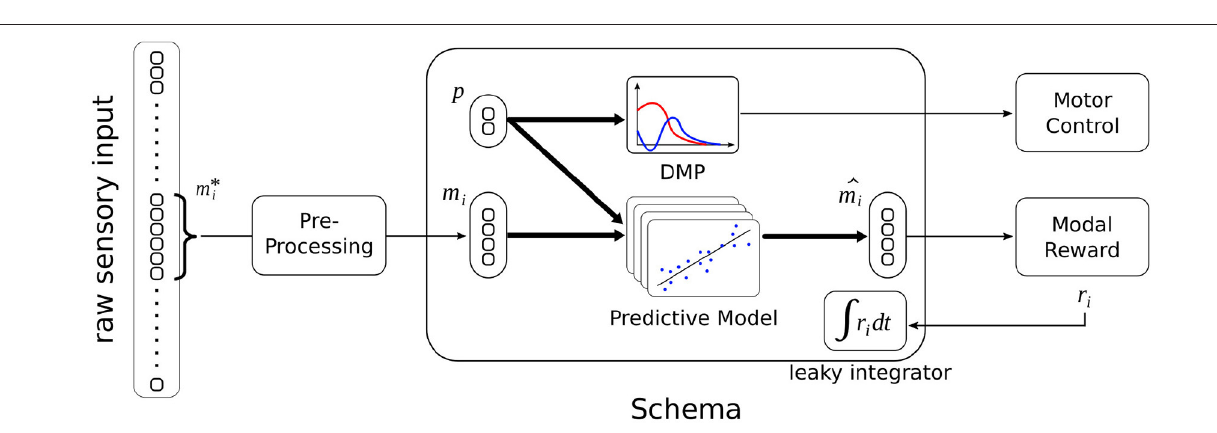
FIGURE 3 | Schematic illustration of the sensorimotor schema in context. Raw sensory data from a specific modality m ∗ i is pre-processed into a lower-dimensional representation m i . After training, given the current modal percept m i and some action parameterized by p , the schema can predict the resulting sensory percept ˆ m i , and get the associated reward r i through the Modal Reward component. Some experiments use the leaky integrated value of the reward (refer to Section 4.6). When the schema is triggered, its DMP is used to control the execution of the